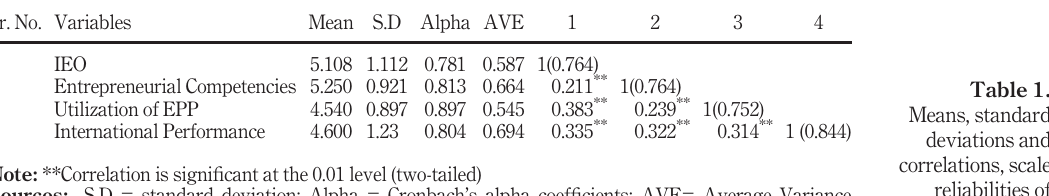
deviations and correlations,